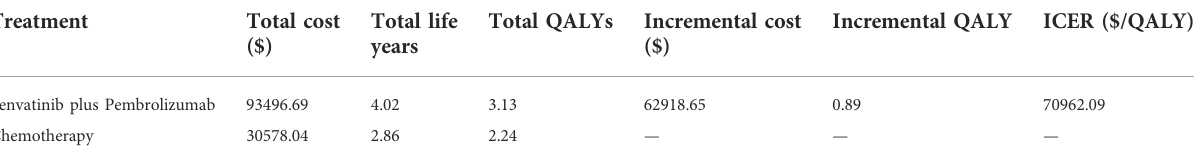
TABLE 2 The results of the cost-effectiveness analysis.